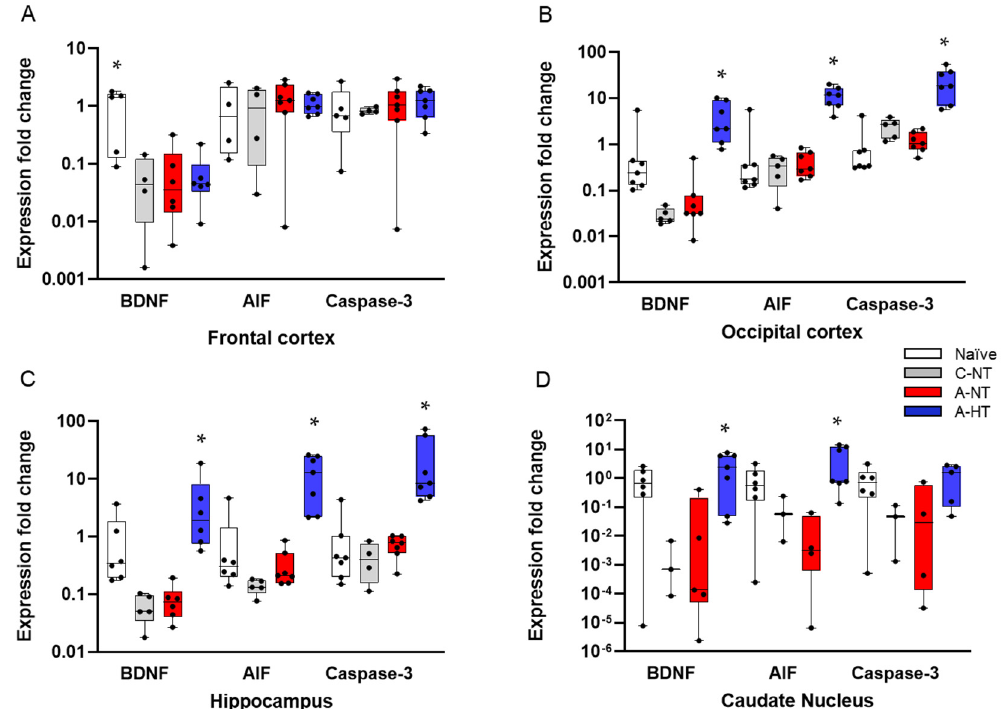
Figure 8. Gene expression data for BDNF, AIF, and caspase-3 genes in four different brain regions. ( A ): In the frontal cortex, BDNF mRNA levels were significantly higher in the naïve (untreated) group, but they were very similar in the control-normothermia (C-NT), asphyxia-normothermia (A-NT), and asphyxia-hypothermia (A-HT) groups. AIF and caspase-3 levels were also very similar in all four groups. ( B ): In the occipital cortex, the mRNA levels of all three genes were significantly elevated in the A-HT group compared to the A-NT group. ( C ): In the hippocampus, an identical pattern of gene expression was observed. ( D ): In the caudate nucleus, BDNF and AIF but not caspase-3 mRNA levels were significantly increased in the A-HT group compared to the A-NT group. Lines, boxes, whiskers, and bullets represent the median, the interquartile range, the 10th–90th percentiles, and raw data, respectively. * vs. A-NT p < 0.05.